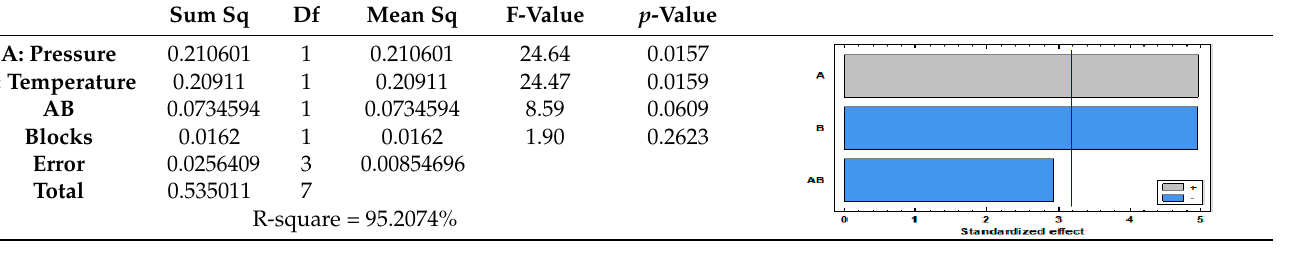
Table 4. ANOVA table and Pareto chart for quadratic model of MLE loading in PETG.